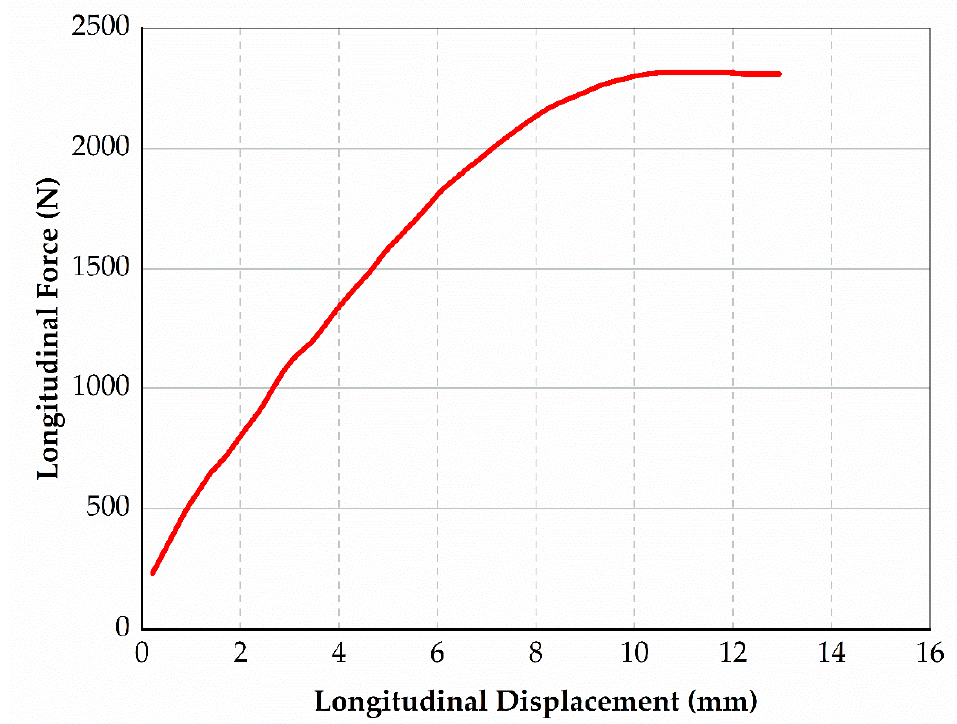
Figure 14. The longitudinal force vs. longitudinal displacement of the original pneumatic tire (175/70 R14).